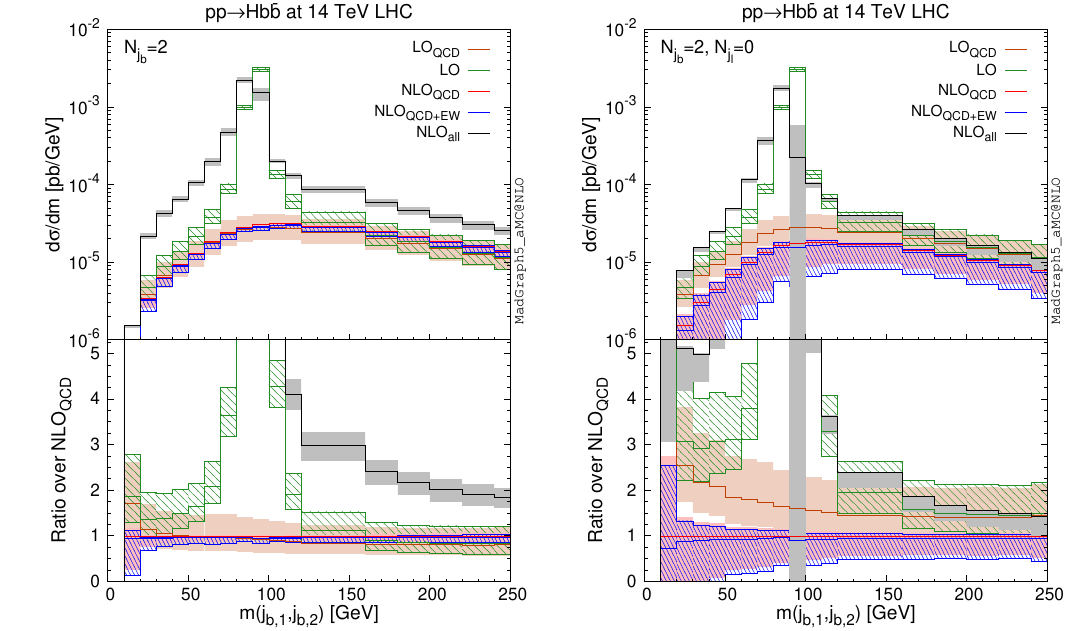
Figure 2 . The m ( j b, 1 , j b, 2 ) distribution for N j ≥ 2 . In the right plot the light-jet veto is applied. b show results with the light-jet veto. In each plot, we show in the lower inset the same quantities of the main panel normalised to the central value of the NLO QCD